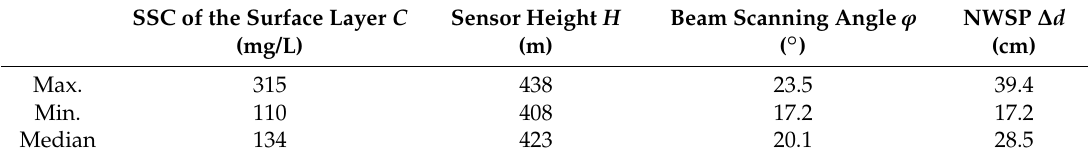
Table 3. Statistical parameters of the four-type data used in the modeling.